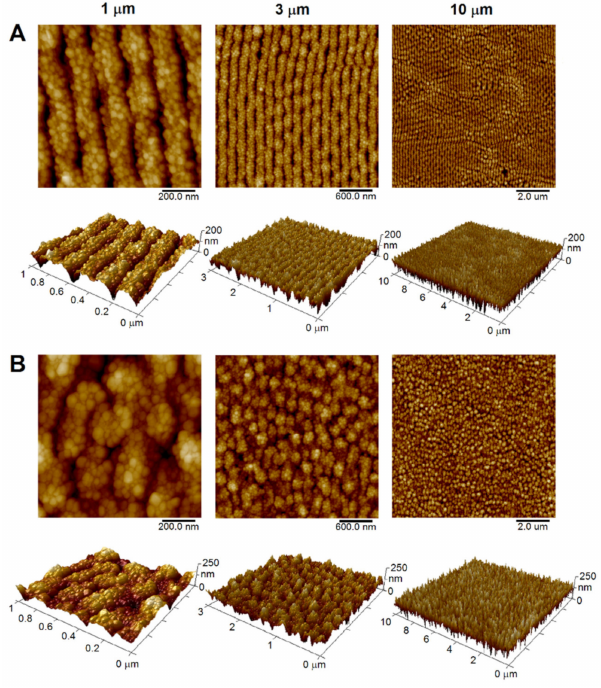
Figure 4. Two-dimensional and three-dimensional AFM images of optomechanically processed AgNPs on PET ( A ) and PEEK ( B ) surface using a KrF laser. Scan sizes of 1, 3 and 10 µ m. Table 2. AFM analysis parameters: average surface roughness ( R a ) and surface area difference (SAD) for PET/AgNPs before (PET/AgNPs) and after (PET/AgNPs + SC) 408 nm semiconductor (SC) laser irradiation. The parameters correspond to Figures 4A and